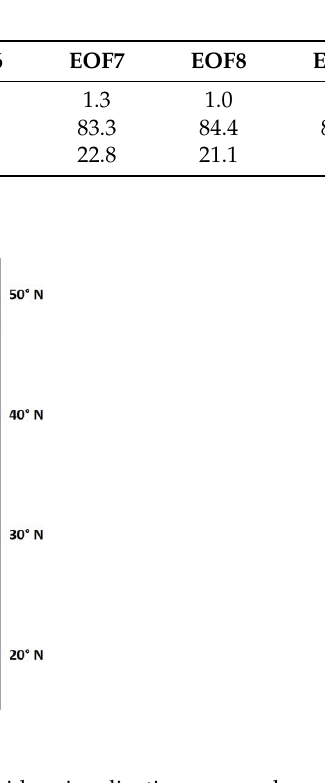
Table 2. Variance contribution (%) of the retained EOFs before rotation, and the difference between the spacin g of adjacent eigenvalues (Δs) and the sampling error (Δλ) , for the retained EOFs tested by North ’ s Rule of Thumb.